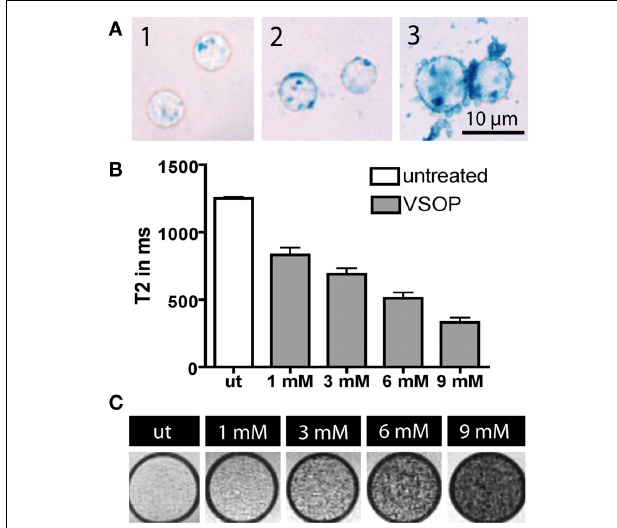
FIGURE 1 |T cell labeling efficiency and magnetic nanoparticle distribution was evaluated microscopically by Prussian Blue staining. Higher labeling concentrations resulted in an augmentation of incorporated VSOP into cytoplasmatic endosomes [ (A1) , 3mM Fe/ml; (A2) , 6mM Fe/ml; (A3) , 9mM Fe/ml]. At a concentration of 9mM Fe/ml,VSOP aggregated and non-specific adherence to the cell surface occurred (A3) .We assessed NMR transverse relaxation times (T2) as a measure of theT cell labeling efficacy by relaxometry (B) .T2 times decreased significantly ( p < 0.001) and in a concentration-dependent manner after incubation ofT cells withVSOP for 20h. Agarose phantoms containing labeledT cells at a concentration of 1000cells/ μ l, imaged at 7T, are presented at different labeling concentrations (ut, untreated; 1–9mM Fe/ml) into (C) .